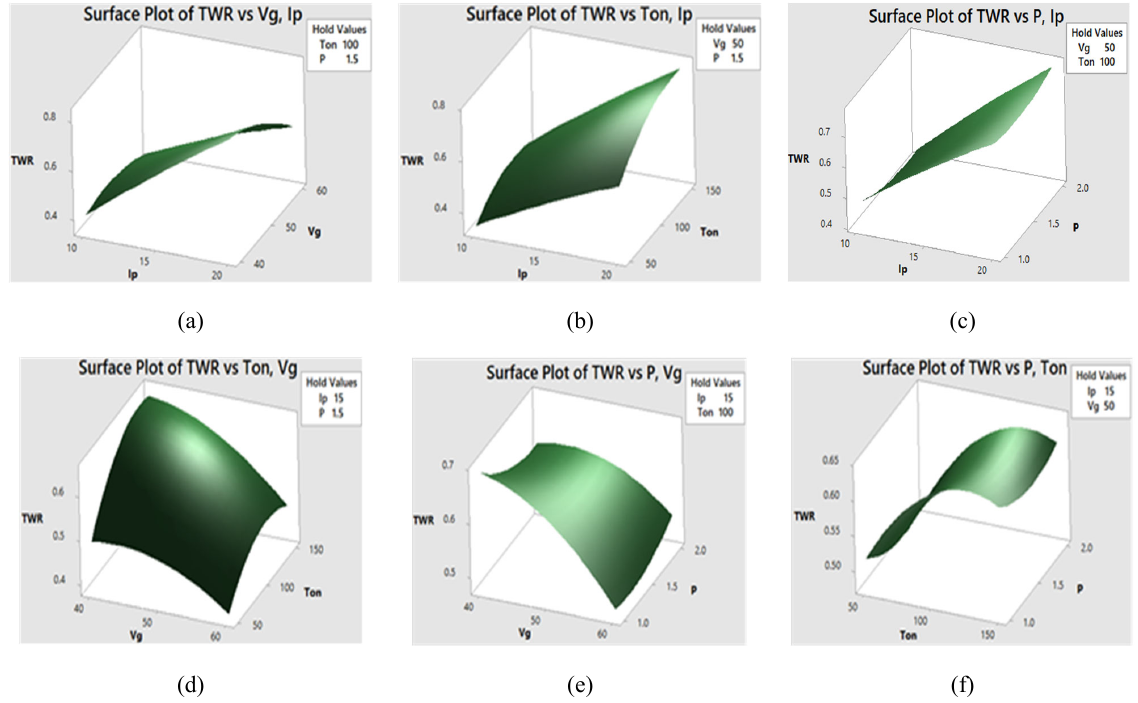
Fig. 6. 3D response surface plots showing (a) the effect of current and voltage(b) the effect of peak current and pulse on time(c) the effect of peak current and flushing pressure (d) the effect of voltage and pulse on time (e) the effect of gap voltage and flushing pressure (f) the effect of pulse on time & flushing pressure on the tool wear rate of Al356/WC MMCs